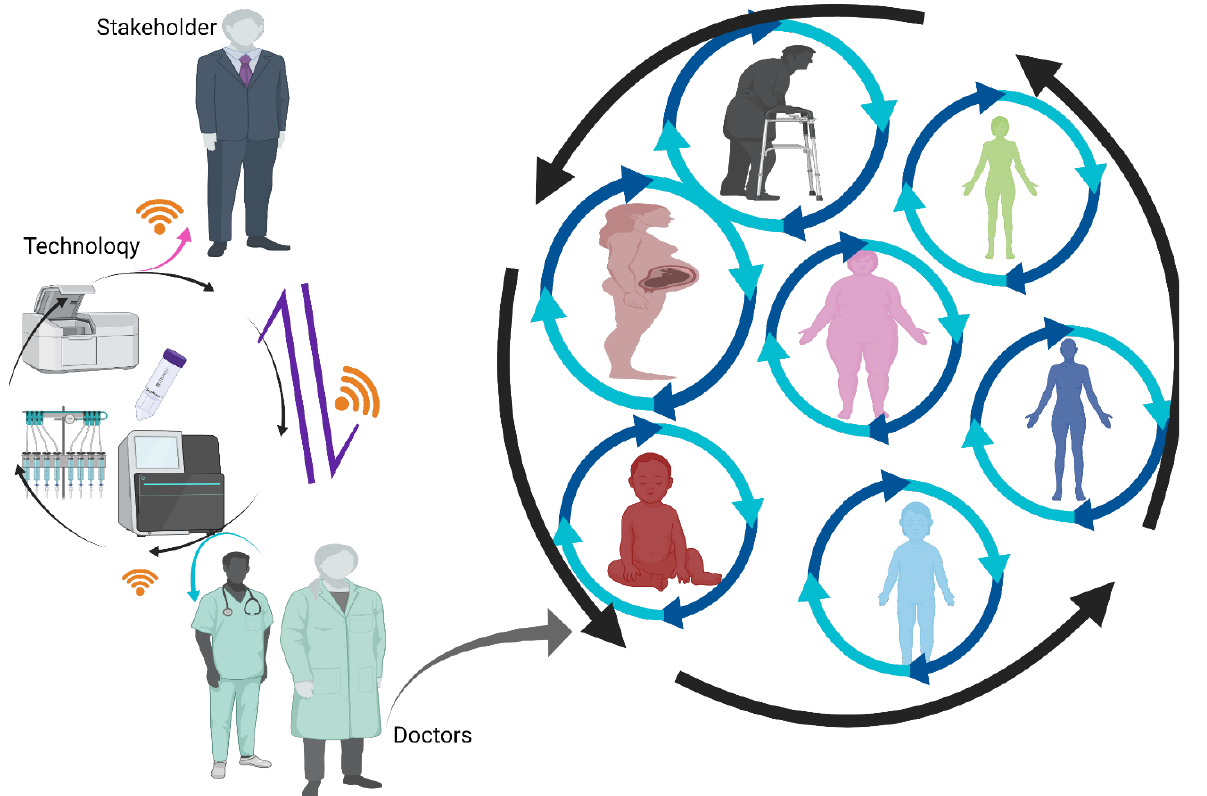
Figure 1. Precision Medicine considers the individual, not the disease. A given illness can be present in all age groups, genders, and physiological/pathological conditions; however, a particular patient presents with different symptoms and responds differently to the same treatment recommendations due to their uniqueness. Bioclinical discoveries need to be implemented specifically according to subject and in order to meet personal needs.